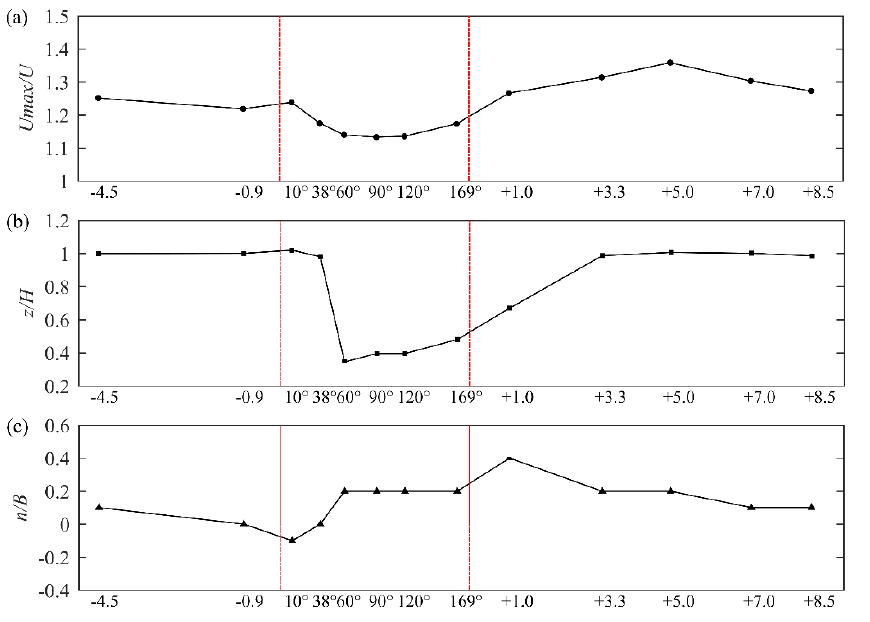
Figure 4. ( a ) Stream-wise evolution (U max /U) of the magnitude of the stream-wise velocity; ( b ) Evolution of the vertical location of U max (z/H); ( c ) Evolution of the span-wise location (n/B) of U max .